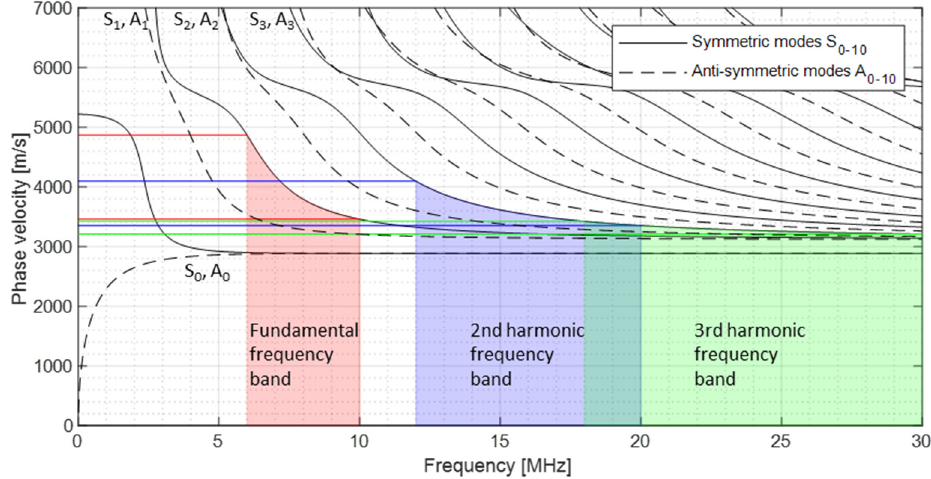
Figure 1. Dispersion curve—phase velocity.